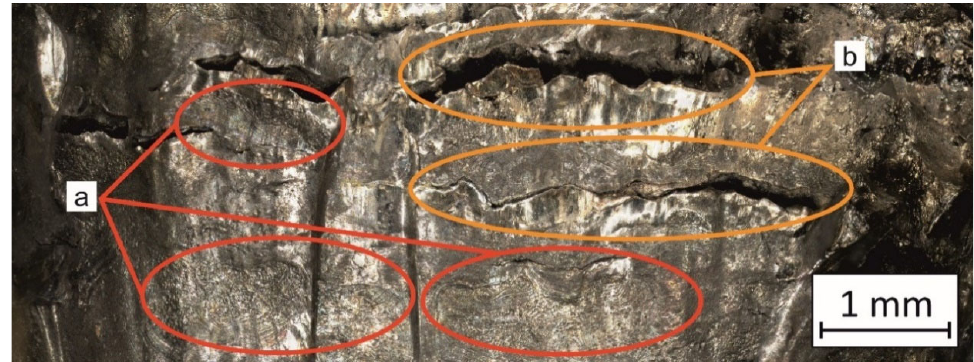
Figure 14. Perforation channel surface with visible deformed areas ( a ) and cracks ( b ) of the BHT plate. In the case of the ATH panel, the perforation channel on the projectile entrance side had an irregular shape due to the brittle tearing of the material which appeared as short and straight crack paths. Further penetration mechanisms caused a radial fracture and detachment of a large material part several times larger area than the projectile’s cross ‐ sectional area. That phenomenon also caused material fragmentation. However, the frag ‐ mentation of the material does not indicate its ballistic resistance as it is only a result of its low ductility. In the cross ‐ section of the perforation channel, a horizontal border was vis ‐ ible (Figure 14, areas b) from which the radial tearing of the material began. It indicates an interlayer cracking mechanism which may be caused by the layered structure of the